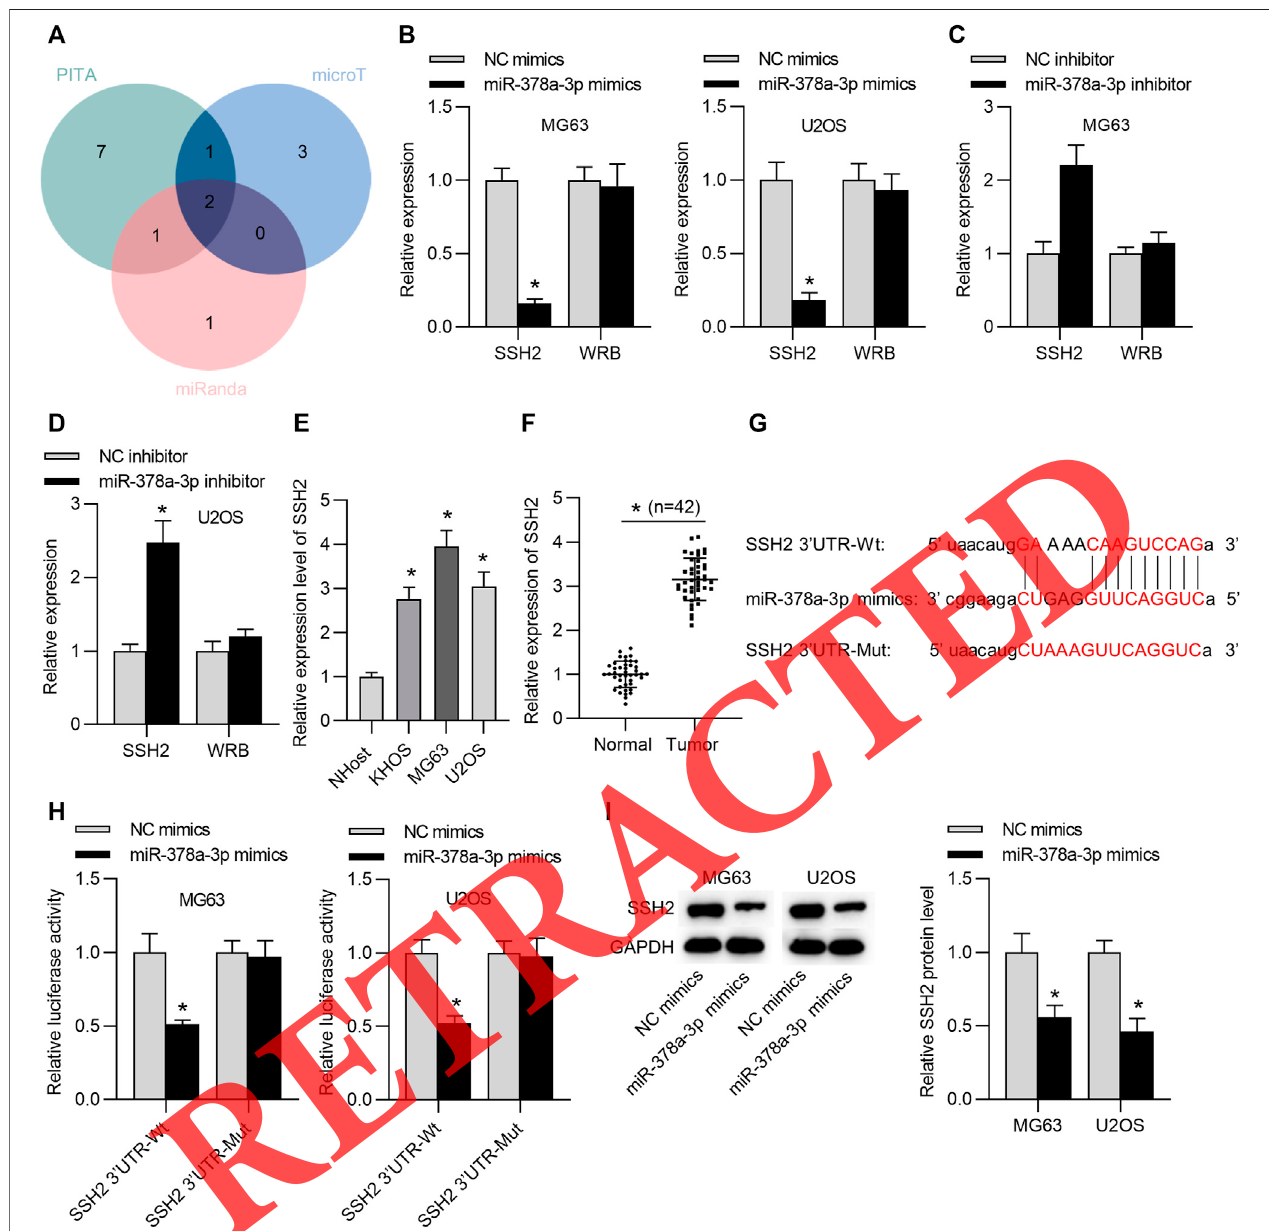
FIGURE 6 | SSH2 is the target gene of miR-378a-3p. (A) The potential mRNAs of miR-378a-3p from PITA, microT and miRanda under the condition of high stringency ≥ 3 on degradome data. (B) The expression of SSH2 or WRB in OS cells in NC mimics or miR-378a-3p mimics group was tested by RT-qPCR. Signi fi cance wasanalyzed by Student ’ st-test. (C,D) The expression ofSSH2 orWRB in OScells transfected withNC inhibitor or miR-378a-3p inhibitor was examined byRT-qPCR. Signi fi cance was analyzed by Student ’ s t-test. (E) The expression of SSH2 in OS cell lines and the normal NHost cells was detected by RT-qPCR analysis. Signi fi cance was analyzed by Student ’ s t-test. (F) The expression of SSH2 in OS tissues and matched normal tissues was detected by RT-qPCR analysis. n (cid:2) 42. Signi fi cance was analyzed by Student ’ s t-test. (G) The binding site between miR-378a-3p and SSH2 3 ′ UTR. (H) The luciferase reporter assay was used to verify the binding ability between miR-378a-3p and SSH2 in OS cells. Signi fi cance was analyzed by Student ’ s t-test. (I) Western blot measured SSH2 protein level in OS cells transfected with NC mimics or miR-378a-3p mimics. Signi fi cance was analyzed by Student ’ s t-test. * p < 0.05.